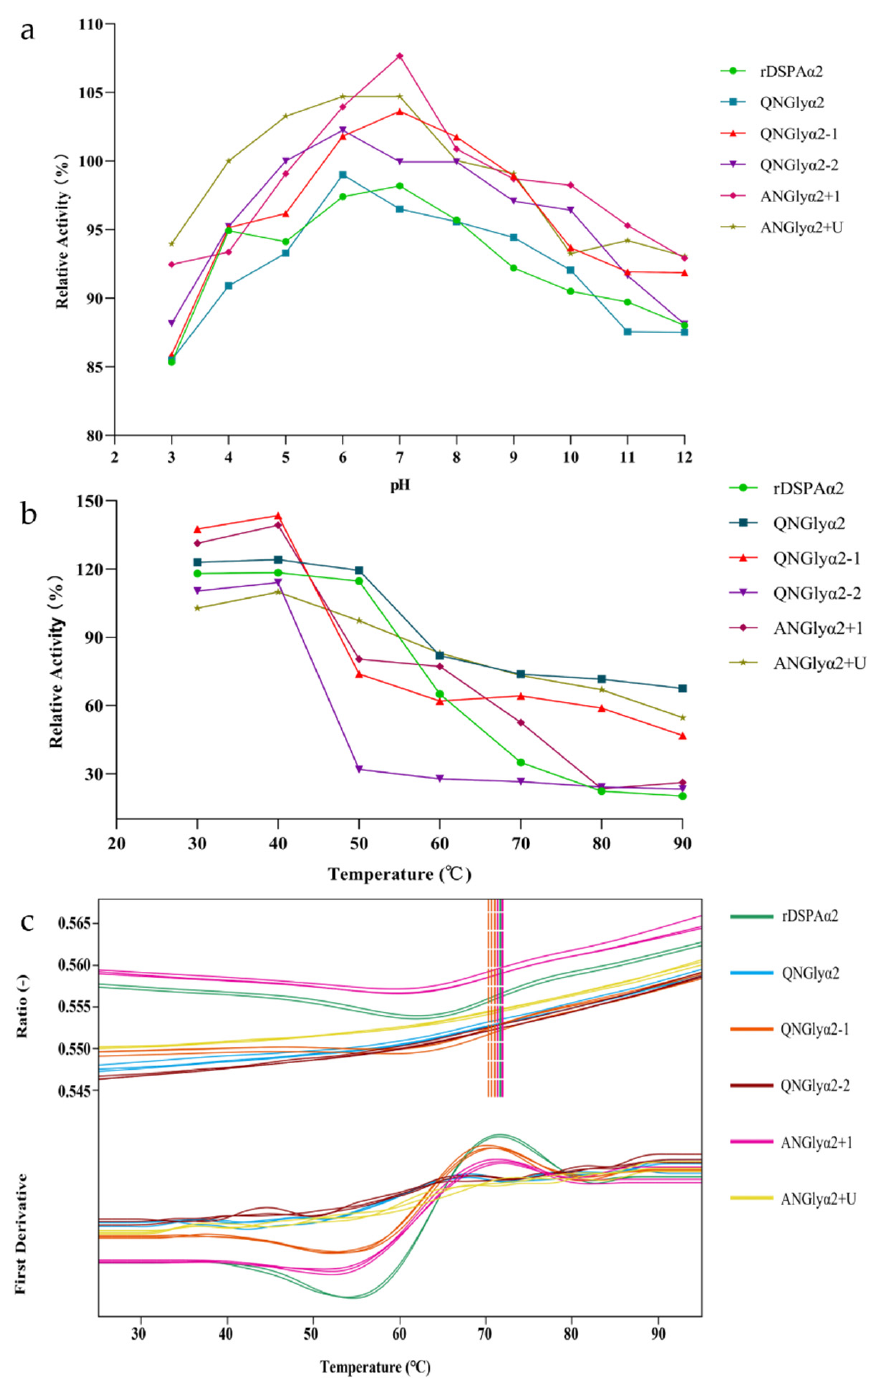
Figure 7. The physicochemical properties of rDSPA α 2 and its mutants against pH and temperature. The curves of different colors represent the different protein samples: green represents rDSPA α 2, blue represents QNGly α 2, orange represents QNGly α 2-1, purple represents QNGly α 2-2, pink represents ANGly α 2+1, and yellow represents ANGly α 2+U. ( a ) The optimal reaction pH. The activities of the different mutants at pH 7.0 were defined as 100%, and the activities at other pHs were compared with the activities at pH 7.0 to obtain their relative activities. The data were presented as the means ± SD (n = 3). ( b ) The optimal reaction temperature. The activities of the different mutants at 4 ◦ C were defined as 100%, and the activities at other temperatures were compared with the activities at 4 ◦ C to obtain their relative activities. The data were presented as the means ± SD (n = 3). ( c ) The thermostability. All samples were assayed using nano-SPDF, with three replicates for each